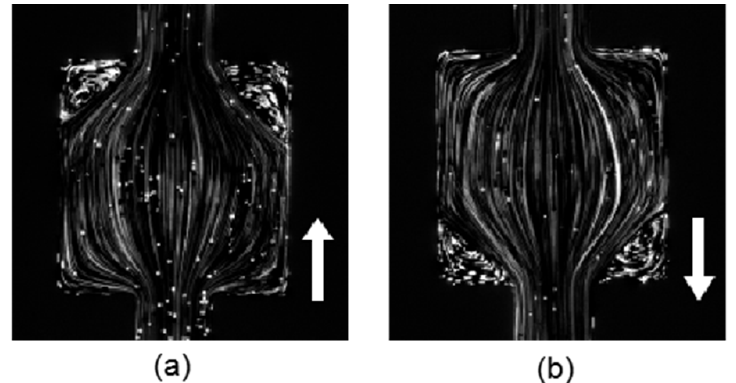
Figure 9. Flow pattern of the glycerol solution in ( a ) forward direction and ( b ) backward direction at Q = 2000 µ L/h. show the flow pattern of the PAM solution at different instants at Q = 300 µ L/h and Wi = 16.67. The flow remained in a symmetric static state, and there was no flow insta- bility. Figure 10d–f show the flow pattern of the PAM solution at different instants at Q = 1000 µ L/h and Wi = 55.56. The flow became asymmetric and unsteady due to the increased normal stress when the flow entered the expansion square chamber and formed an extensional flow. As the flow rate Q increased to 2000 µ L/h and Wi = 111.11, the asymmetry and instability of the flow pattern became more obvious, as presented by the three different patterns shown in Figure